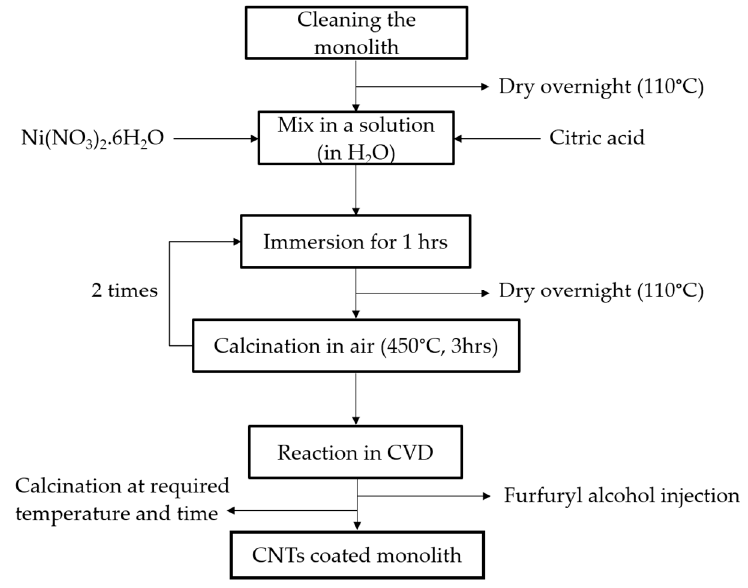
Figure 11. Flowchart for the synthesis of CNT monolith using a CVD system.